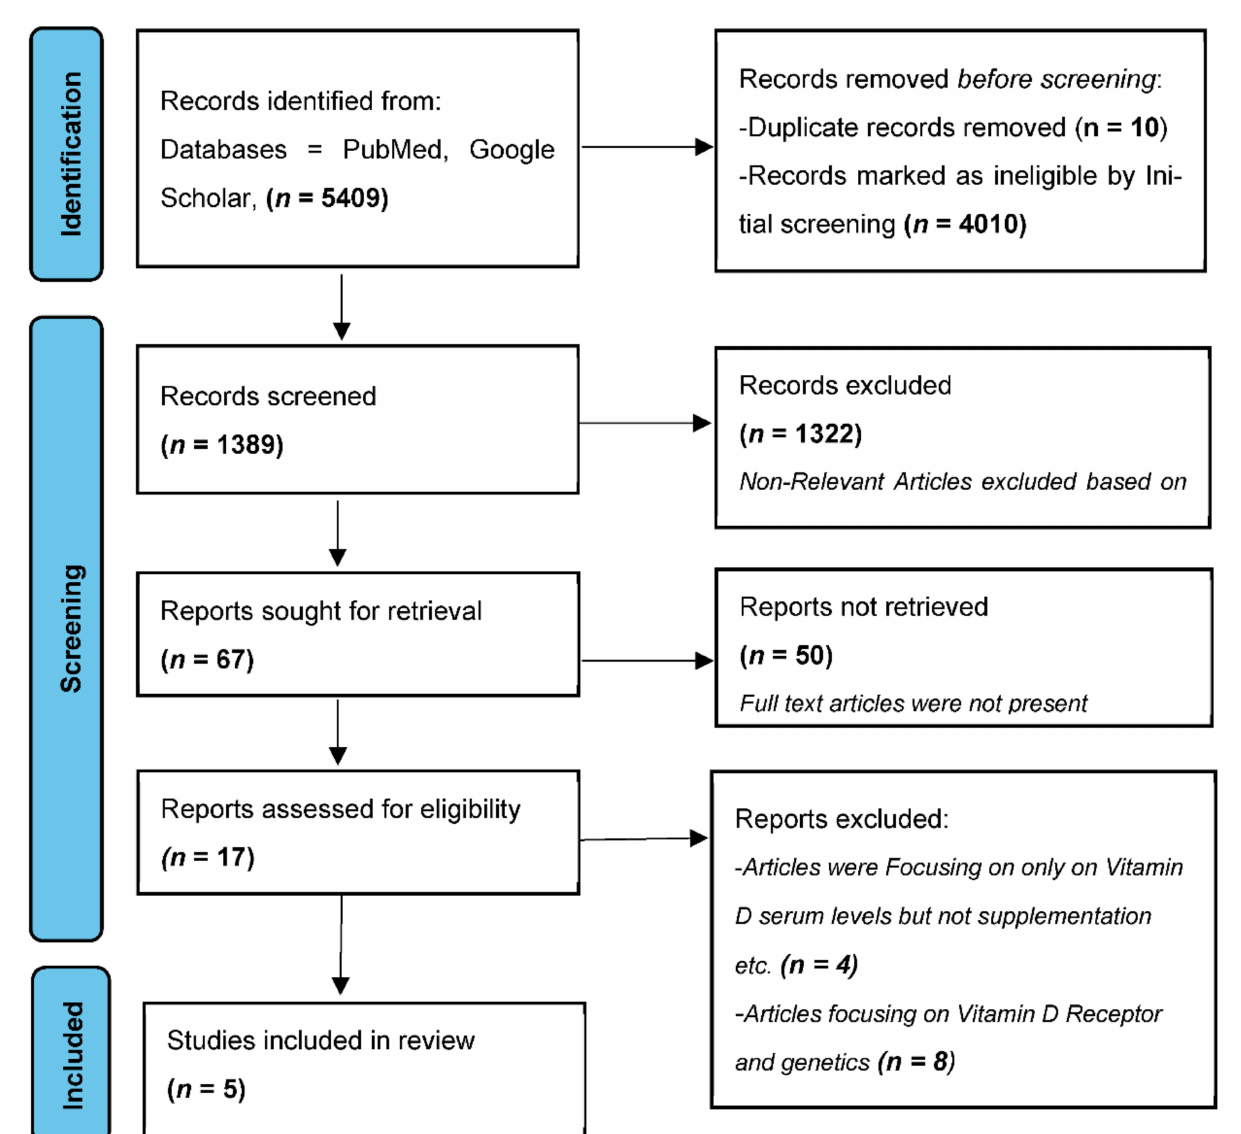
Figure 1. PRISMA flowchart showing the process of study